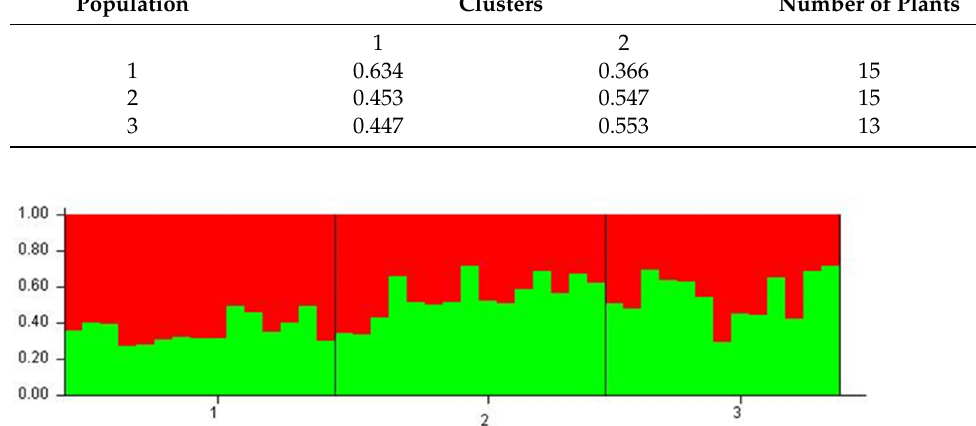
Table 8. The proportion of members of each predefined population in the two groups. Population Clusters